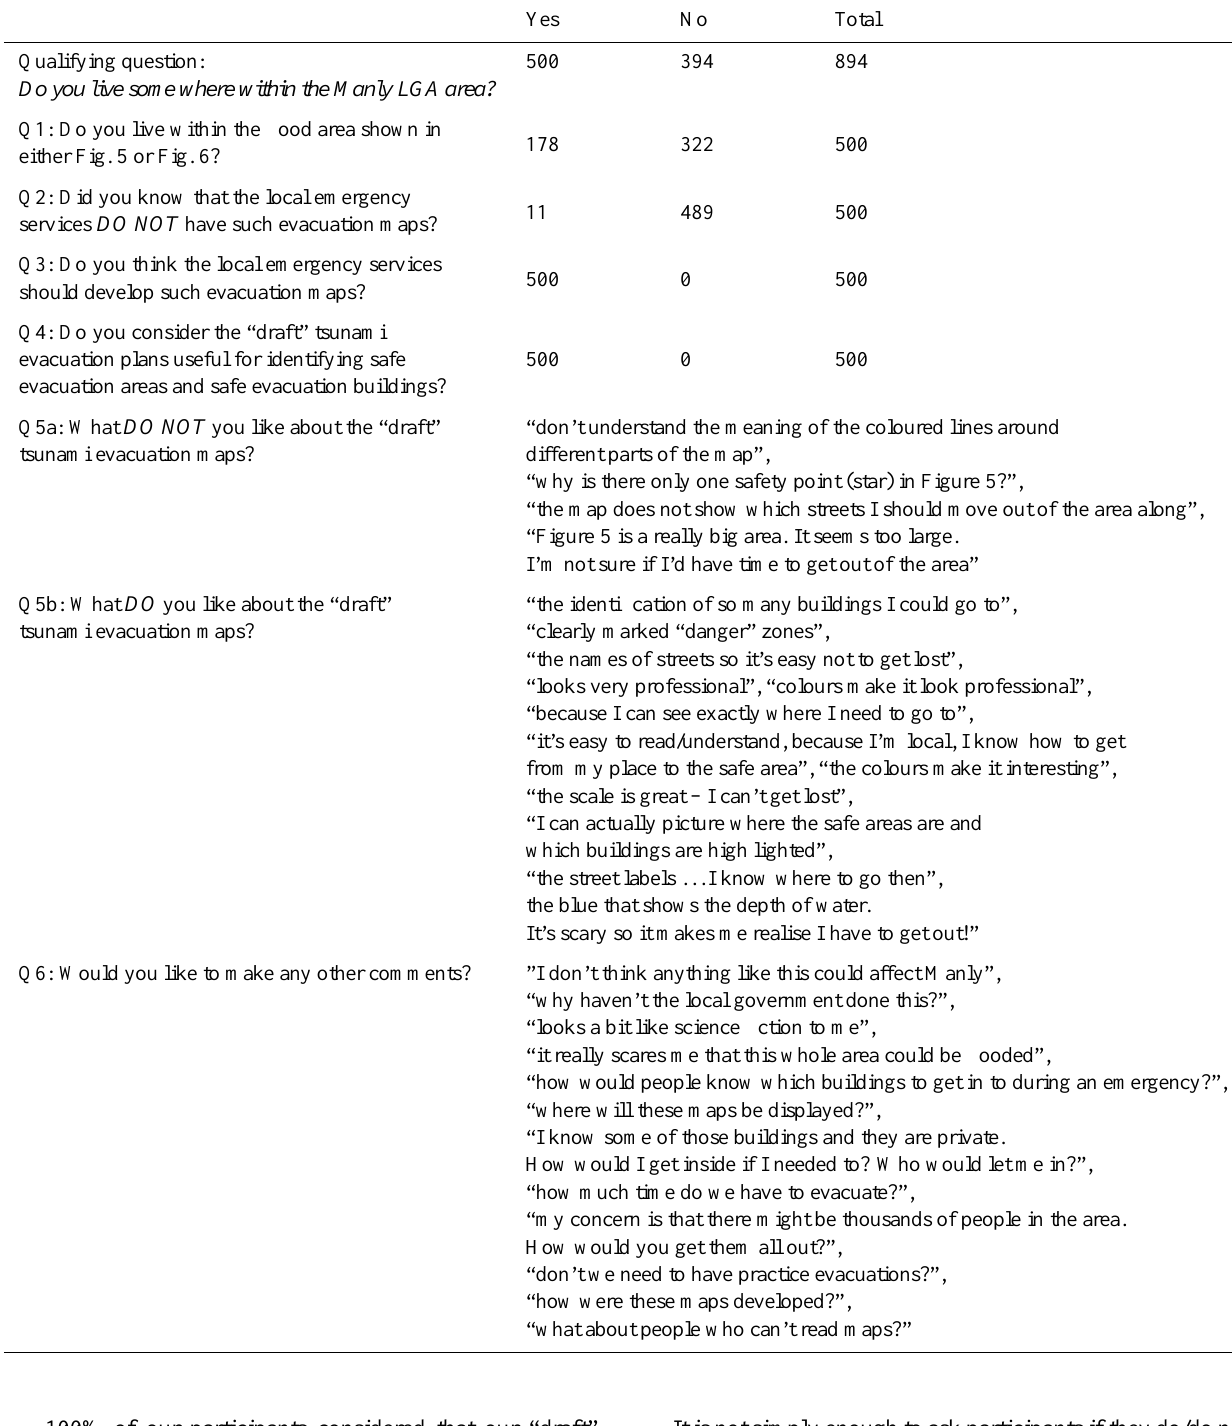
Table 1. A quick look summary of the Short Survey questionnaire we used and the